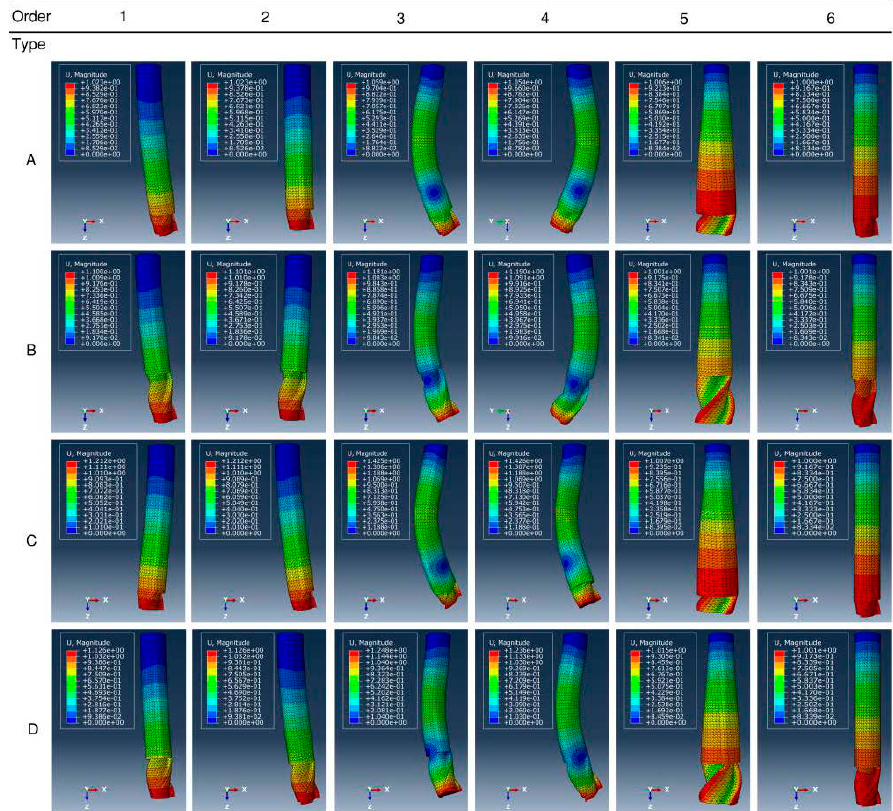
Figure 9. Comparison of the first six modes of ( A – D )-type end milling cutter.